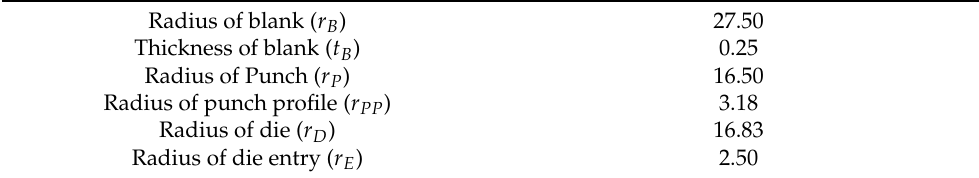
Table 2. The specific dimensions of the tools for cup drawing (mm).